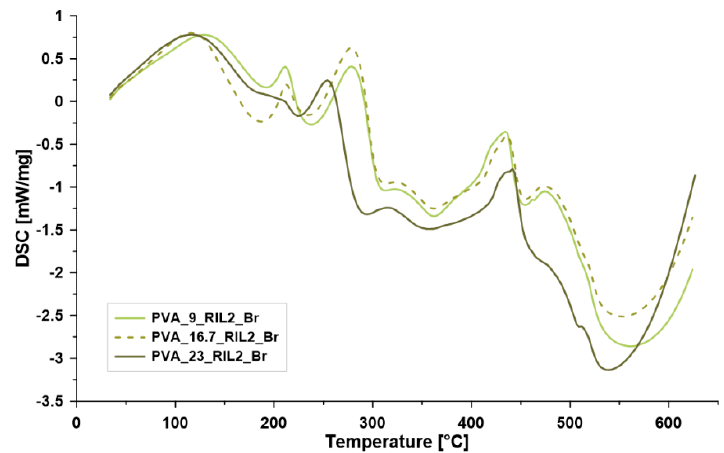
Figure 7. Differential scanning calorimetry (DSC) curves for the investigated membranes PVA-9- Figure7. Di ff erentialscanningcalorimetry(DSC)curvesfortheinvestigatedmembranesPVA-9-RIL2_Br, RIL2_Br, PVA-16.7-RIL2_Br, and PVA-23-RIL2_Br (exo-energetic processes—peaks down). PVA-16.7-RIL2_Br, and PVA-23-RIL2_Br (exo-energetic processes—peaks down).